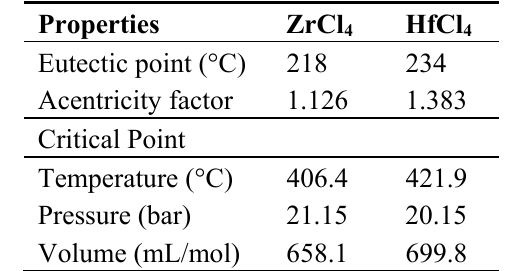
Table 2. Physical properties of the hypothetical ZrCl 4 and HfCl 4 components over the molten salt system (34.0 mol% NaCl and KCl (8:29 M); 66.0 mol% ZrCl 4 and HfCl 4 ) estimated from Aspen